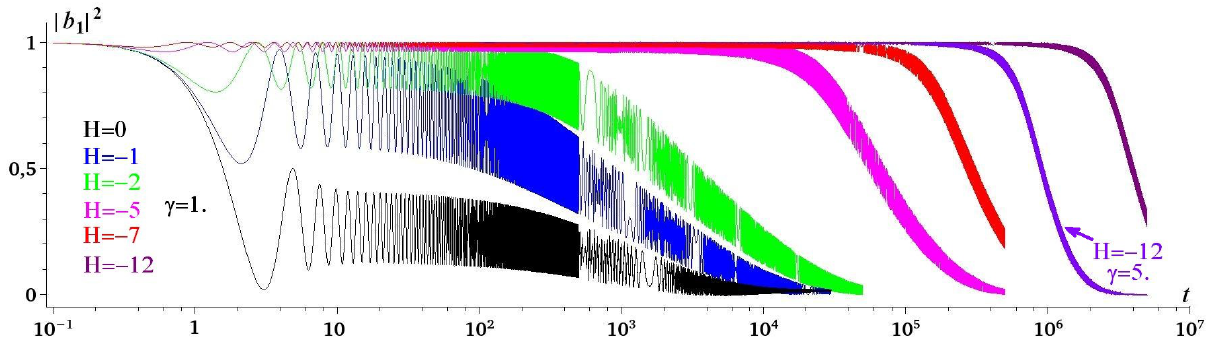
Figure 4. The probability of finding a charge on the first site for di ff erent values of the electron energy H ≤ 0. For H = − 12 the graphs for friction values γ = 1 and γ = 5 (indicated by arrow) are given, for other values of H γ = 1. Behavior of the graphs for H = 0, − 1, − 2 at t = 500 is changed due to increasing of the output interval of the results when the trajectory is